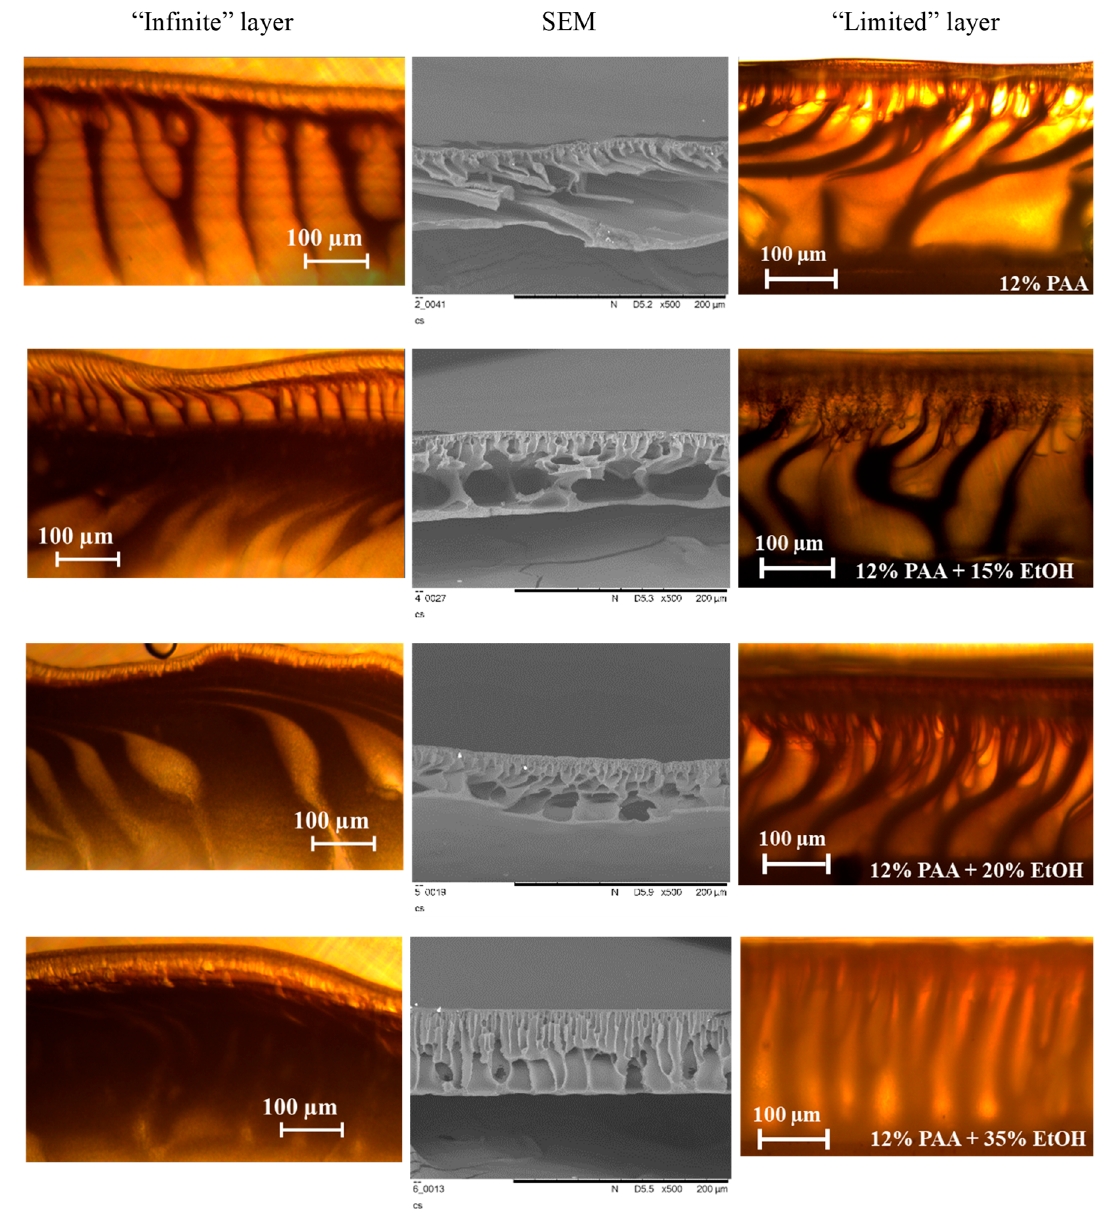
Figure 7. E ff ect of ethanol concentration on the PAA film formed from “infinite” ( left ) and “limited” Figure 7. Effect of ethanol concentration on the PAA film formed from “infinite” (left) and “limited” ( right ) layer of a polymer solution, and SEM cross-section of the membrane ( center (right) layer of a polymer solution, and SEM cross-section of the membrane (center).